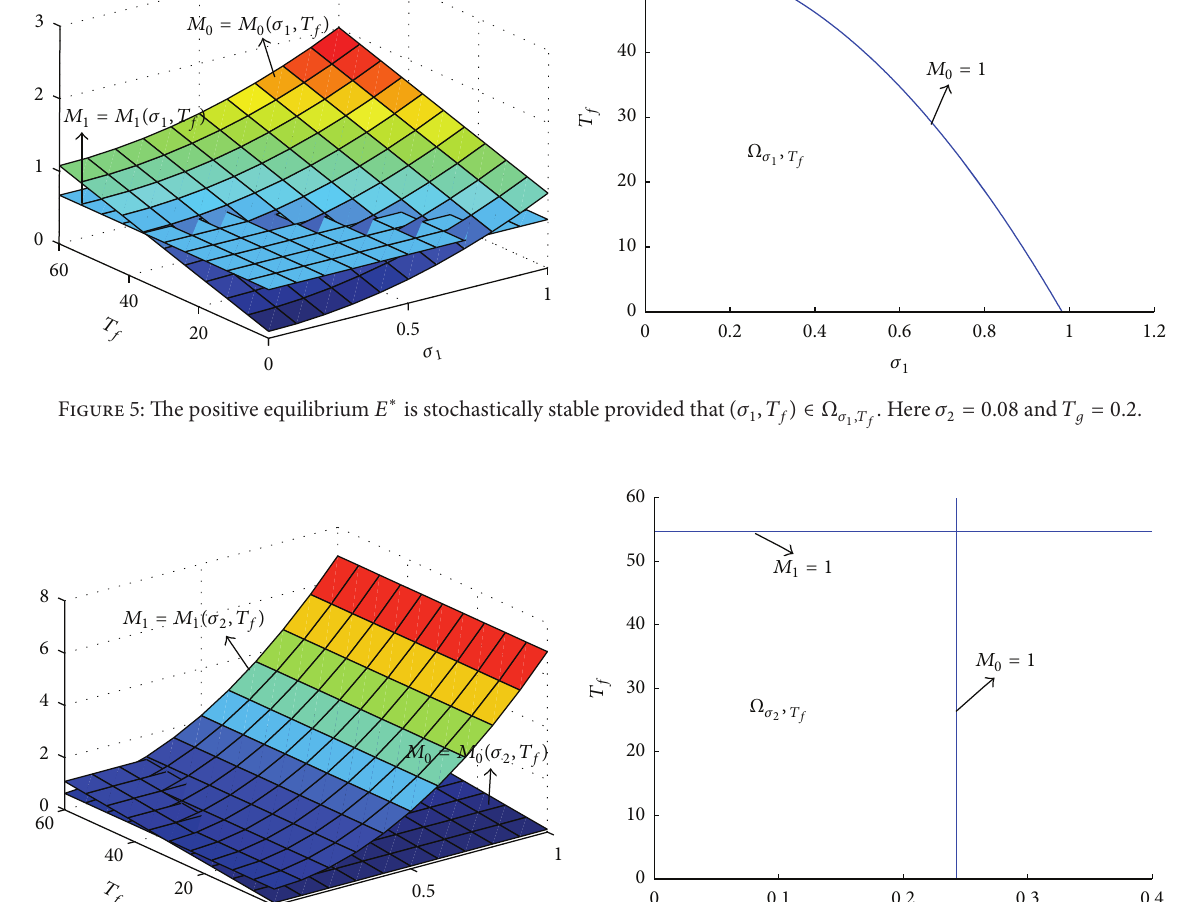
. Here 𝜎 1 = 0.1 and 𝑇 𝑔 = 0.2 . 2 ,𝑇 𝑓